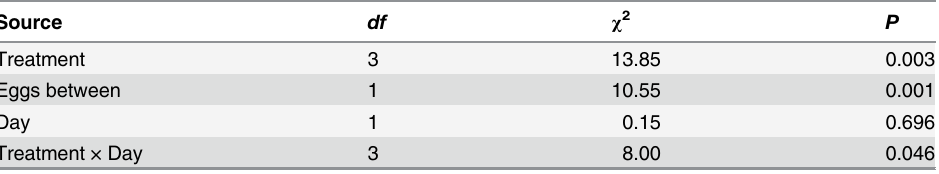
Table 2. Generalized linear model of the effects of three molecular-weight fractions of male accessory gland extract (treatment) and the number of days in between matings (days) on the sperm